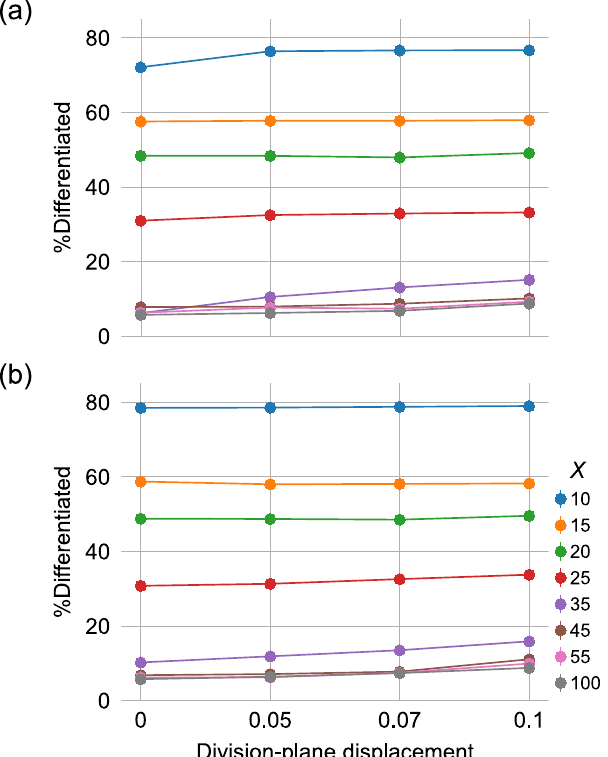
Fig 3. The stochastic positioning of the division plane and the random distribution of TFs in the cytoplasm, as intrinsic sources of noise, affect the non-genetic phenotypic diversity (component #2). The phenotypic diversity is represented by the proportion of cells with the phenotype B relative to the total number of cells in the population. In panel (a), the only source of noise is the stochastic positioning of the division plane ( σ 2 = 0.1), while panel (b) shows the phenotypic diversity as a result of both variance in division-plane ( σ 2 = 0.1) and the noise resulting from drawing the number of TFs at any location along the cell at random from a uniform distribution. In each panel, the curves indicate different amounts of protein X in the mother cell. The results are average over 100 replications. Error bars are 95%CI. The error bars are too small to be seen.